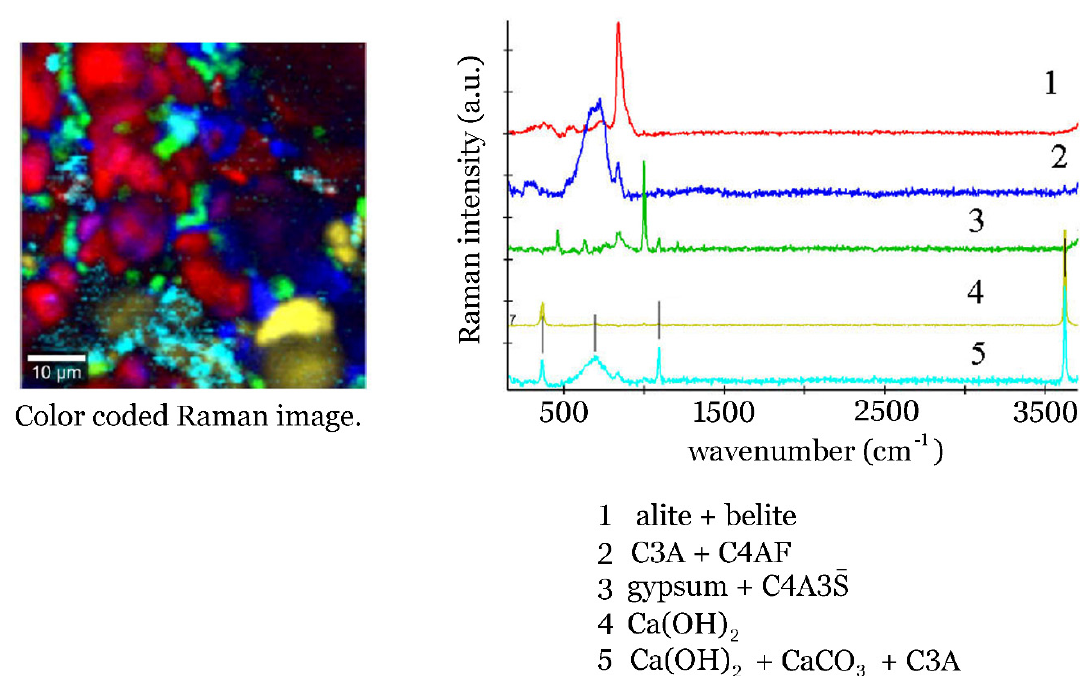
Figure 6. Colour coded Raman image of the 60-micrometer by 60-micrometer area of the clinker 217 grain. Spectral components given on the right-side result from the software analysis.